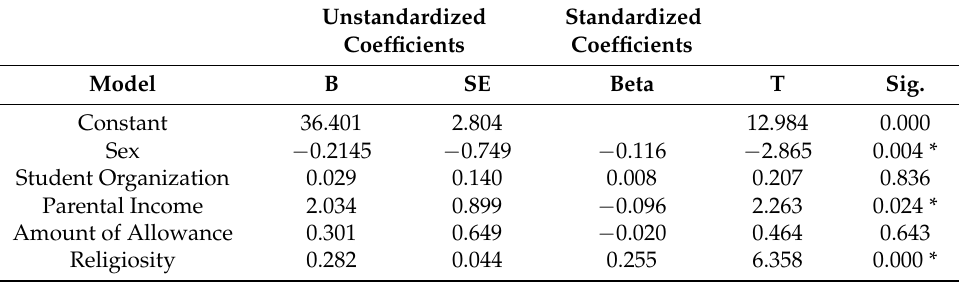
Table 6. Regression coefficients for each independent